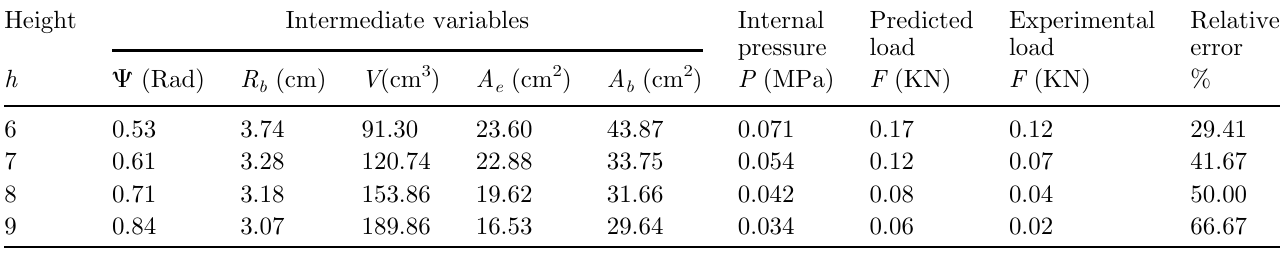
Table 9. Calculation results of arbitrary height of air spring. Height Intermediate variables